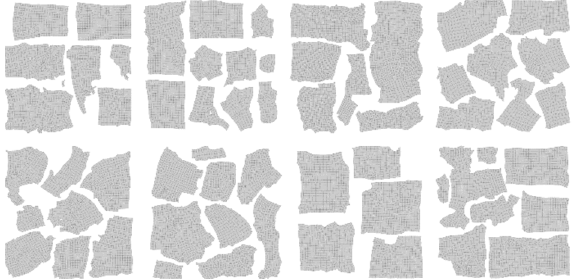
Figure 7. Regularized manual UV unwrap of tunnel 13 model in eight different maps.